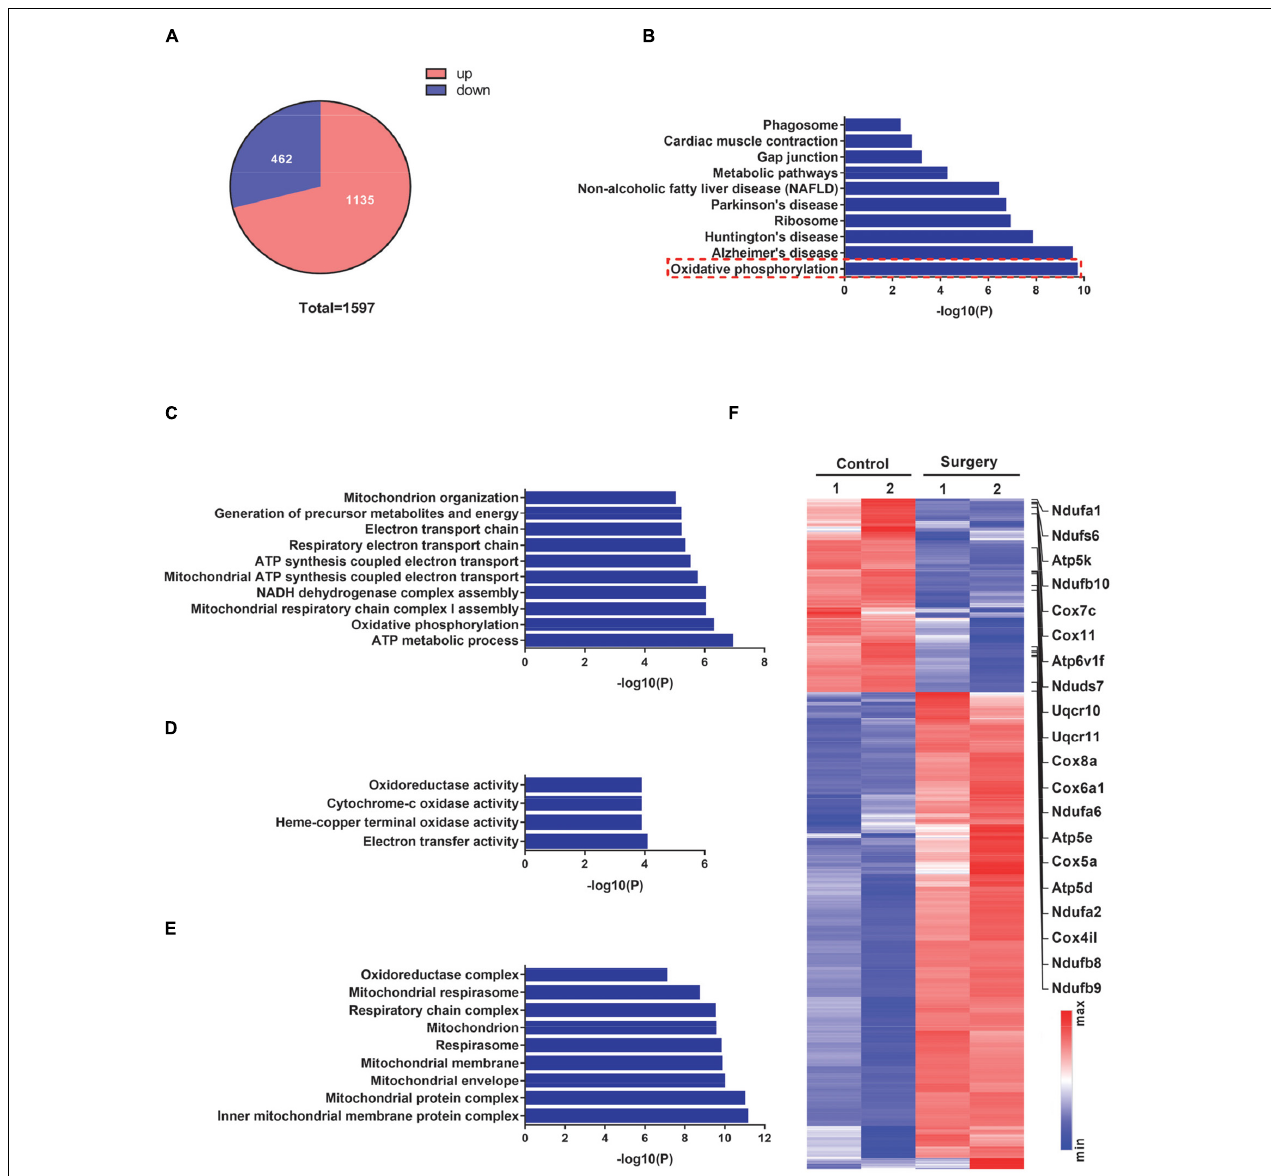
FIGURE 2 | Transcriptome profiles of hippocampal tissues from control mice and mice at 1 day after surgery. (A) Pie chart demonstrating the total number of differentially expressed genes (DEGs) (fold-change cutoff = 1.5) and the number of significantly up- and downregulated genes (surgery vs. control). (B) Kyoto Encyclopedia of Genes and Genomes (KEGG) pathway analysis for significantly downregulated genes in (A) . (C–E) Biological process (C) , molecular function (D) , and cellular component (E) from Gene Ontology (GO) analysis for significantly downregulated genes in (A) . (F) DEGs in the surgery vs. control groups were visualized in a heatmap. Oxidative phosphorylation-related genes are indicated on the right side of this heatmap.